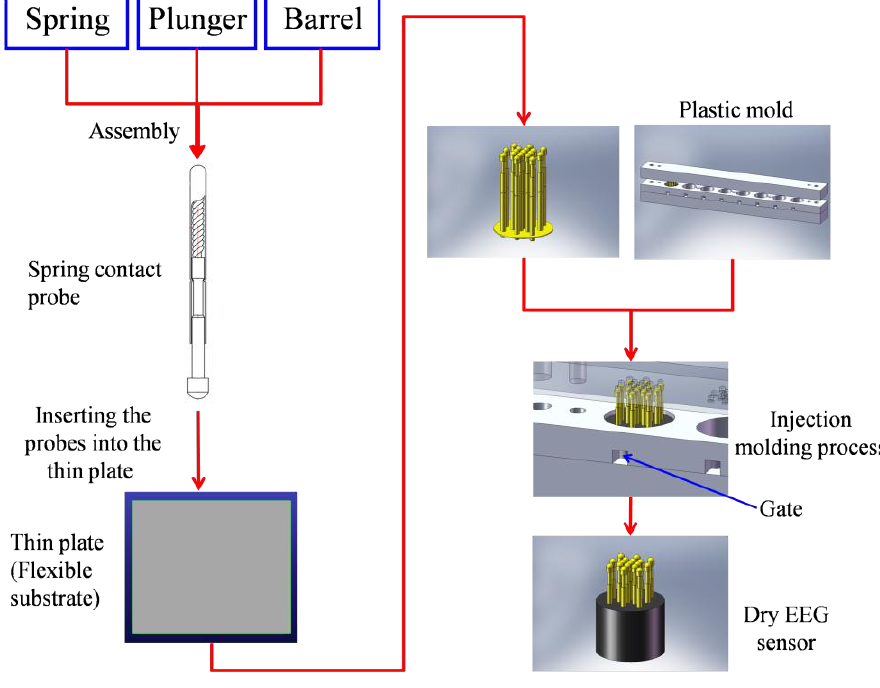
Figure 2. The fabrication process of novel dry EEG